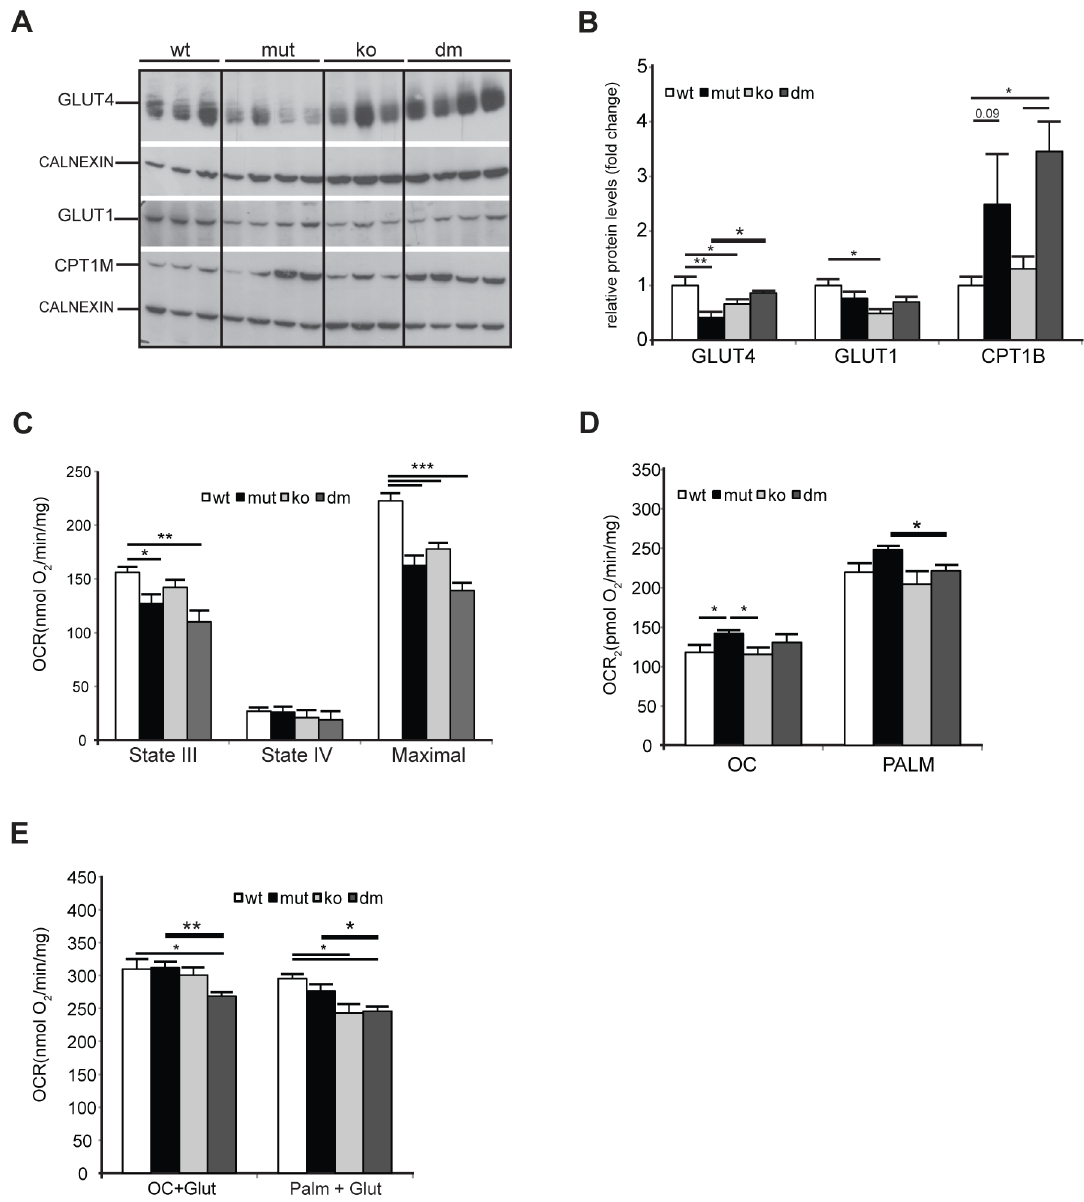
Figure 5. UCP2 promotes fatty acid oxidation in mtDNA mutator mitochondria. (A) Steady-state levels of mitochondrial glucose and fatty acid transporters: insulin-regulated glucose transporter (GLUT4), basal glucose transporter 1 (GLUT1) and mitochondrial carnitine palmitoyltransferase I (CPT1B) in wild type (wt), mtDNA mutator (mut), UCP2-deficient wild type (ko) and mtDNA mutator (dm) mice. Cytoplasmic calnexin was used as loading control. (B) Quantification of Western blots from (A). (C) Oxygen consumption rates in intact mitochondria in presence of pyruvate- glutamate-malate as substrates. State III (substrates + ADP); State IV ( + oligomycin); MAX ( + CCCP). (D) Oxygen consumption rates in intact mitochondria in the presence of medium (OC - octanoyl-carnitine) or long chain (PALM - palmitoyl-carnitine) fatty acids as substrates. (E) Maximal oxygen consumption rates upon addition of octanoyl-carnitine + glutamate (OC + Glut) or palmitoyl-carnitine + glutamate (PALM + Glut) to intact mitochondria. (n=4–6). Bars indicate mean levels 6 standard error of the mean (S.E.M.). Statistically significant differences between mut and dm are presented with thick lines. Asterisks indicate level of statistical significance (*p , 0.05 **p , 0.01 ***p , 0.001, Student’s t -test).